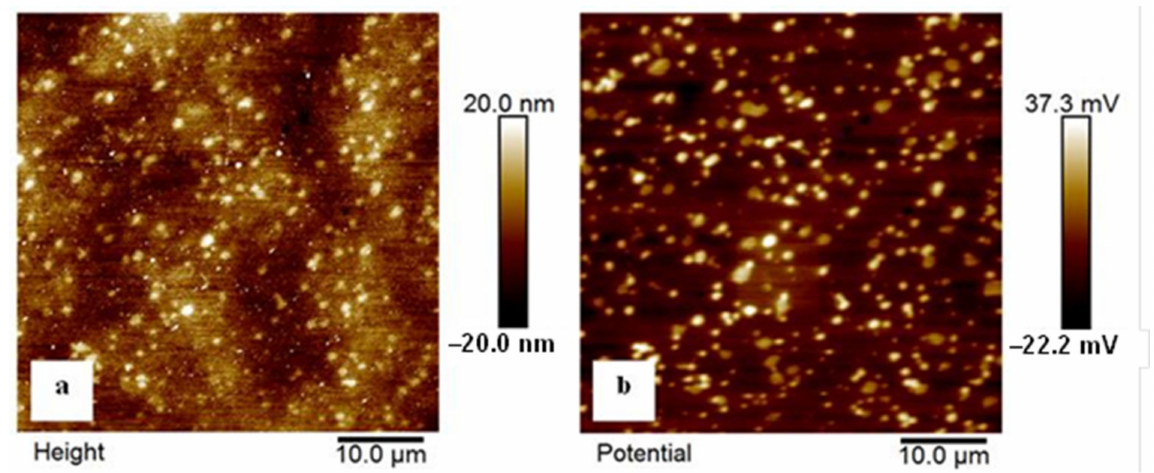
Figure 14. KPFM images of the examined steel sample that was subjected to the SZT at − 140 ◦ C. ( a ) Topography and ( b ) work function mapping. Image size 50 × 50 µ m 2